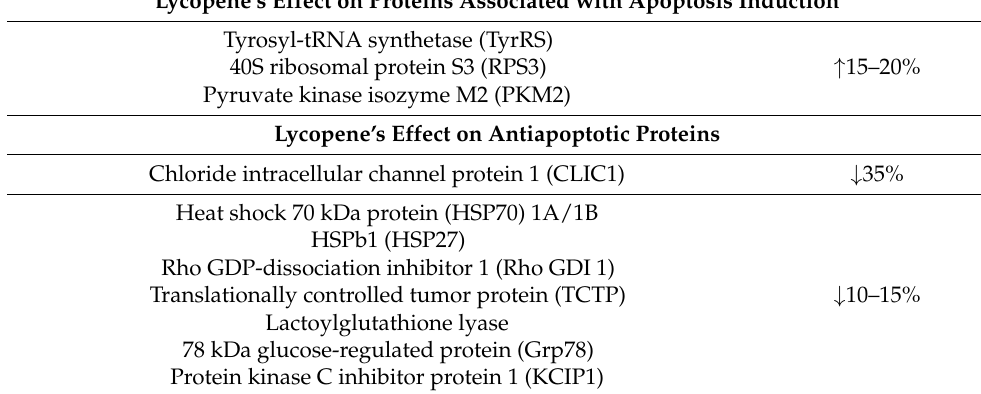
Table 6. The influence of lycopene on the expression of proteins involved in the process of apopto- sis [131]. Lycopene’s Effect on Proteins Associated with Apoptosis